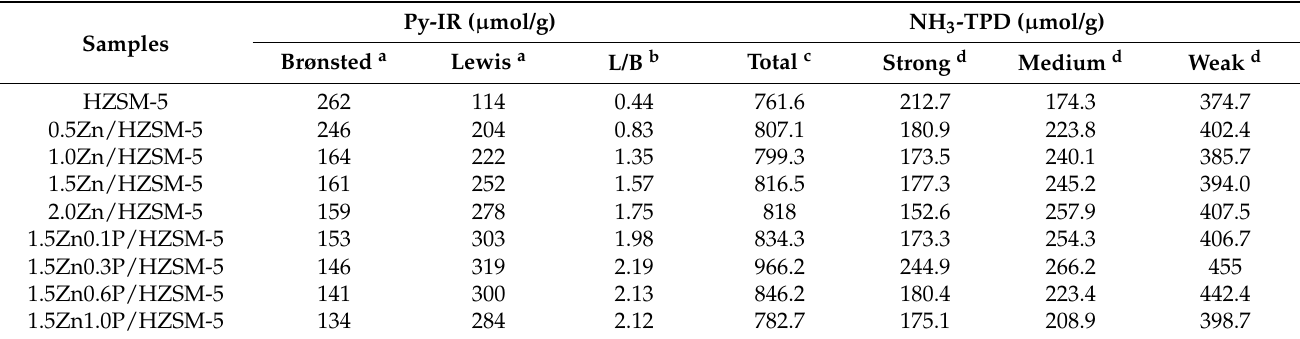
Table 2. Acid amounts of Zn modified and Zn-P co-modified